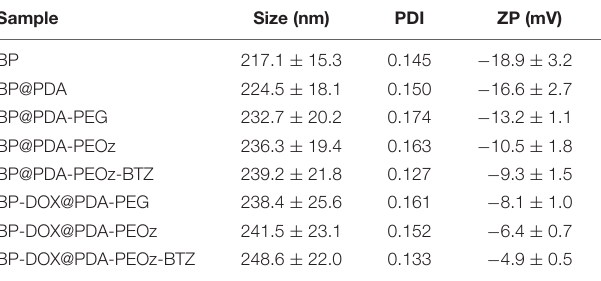
TABLE 1 | Characterization of BP-based NSs in deionized